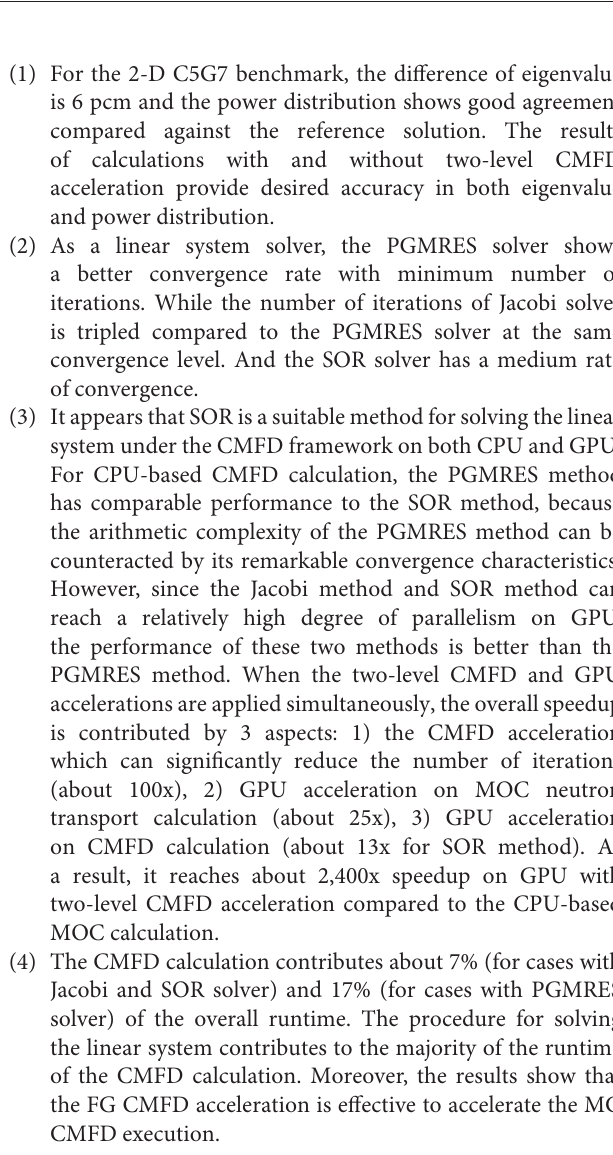
FIGURE 6 | (A) Time break down of CMFD calculations on CPU. (B) Time break down of CMFD calculations on